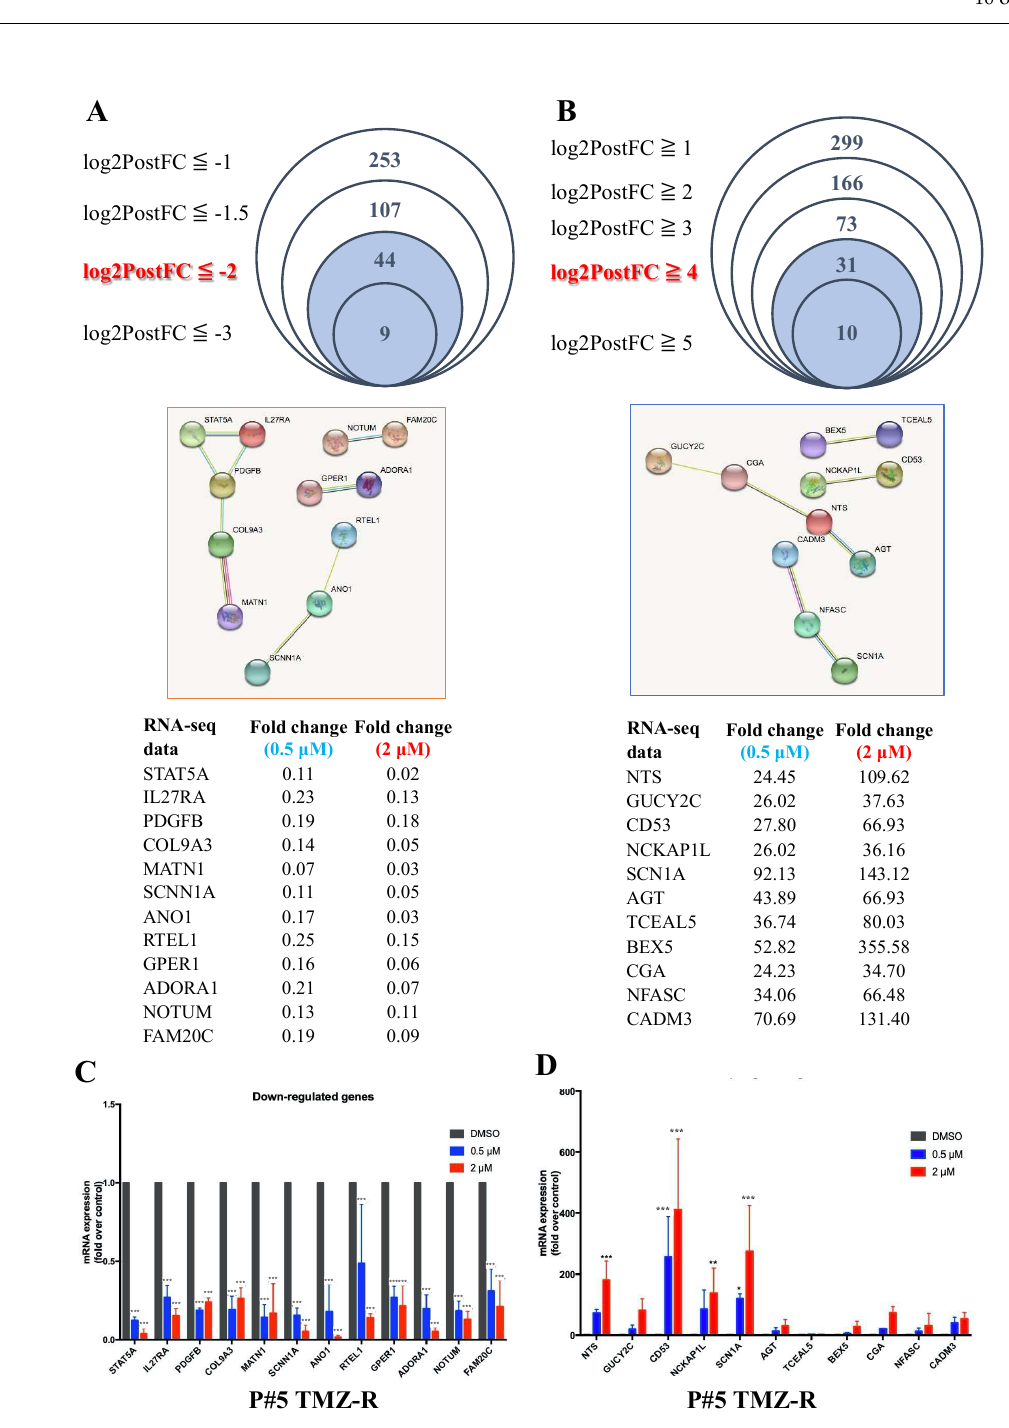
Figure 4. Intergroup comparison of the RNA-seq data after LMK235 treatment. ( A ) Forty-four DEGs were selected by the criterion of log2PostFC < − 2, and 12 DEGs were further selected by screening their linkage to each other in the STRING database. ( B ) Thirty-one DEGs were selected by the criterion of log2PostFC > 4, and 11 DEGs were selected by screening their linkage to each other in the STRING database. The upregulated ( C ) and downregulated ( D ) mRNA expression levels of the DEGs mentioned above were verified by qPCR. * indicates comparison with vehicle; mean ± SEM. * p < 0.05, ** p < 0.01, *** p < 0.001.